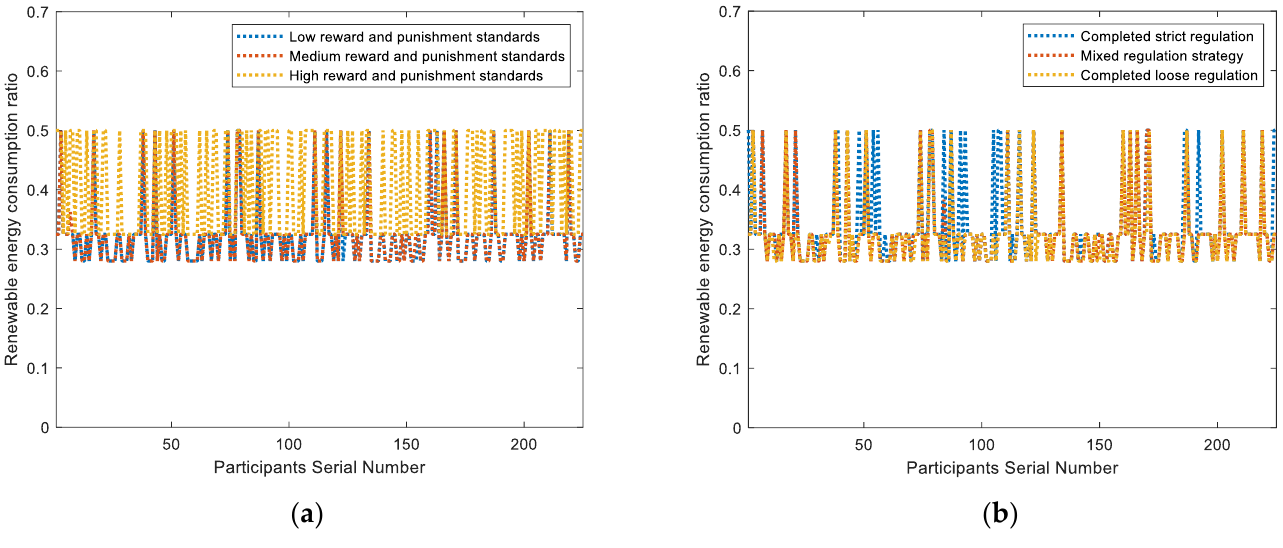
Figure 7. Sensitivity analysis of the completion of the weight of the market entity’s consumption responsibility. ( a ) The completion of the consumption responsibility weight of market entities under different levels of rewards and punishments. ( b ) The completion of the consumption responsibility weight of market entities under different levels of government supervision.